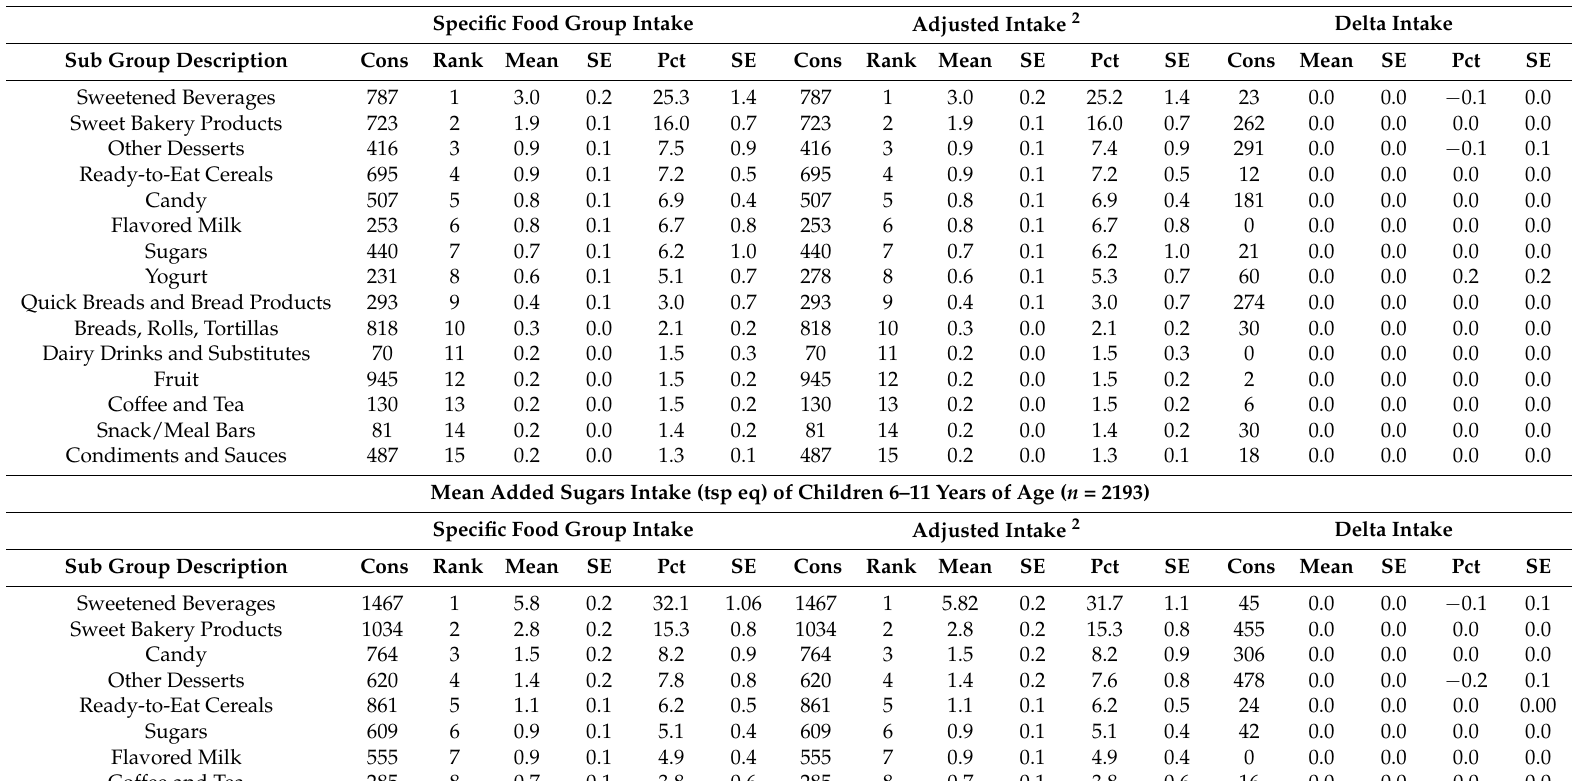
Table 6. Food/food group sources 1 of mean added sugars (tsp eq) intake among US children aged 2–18 years ( N = 5876): National Health and Nutrition Examination Survey